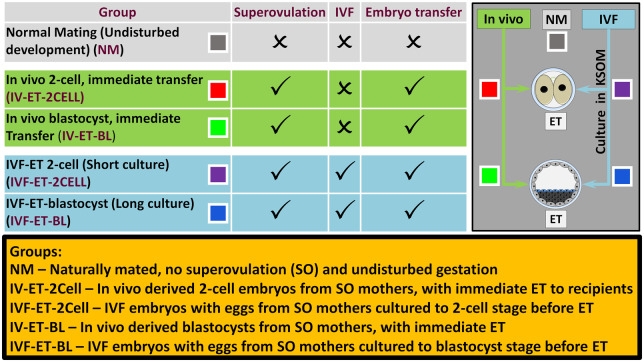

Experimental design showing the five treatment groups used.